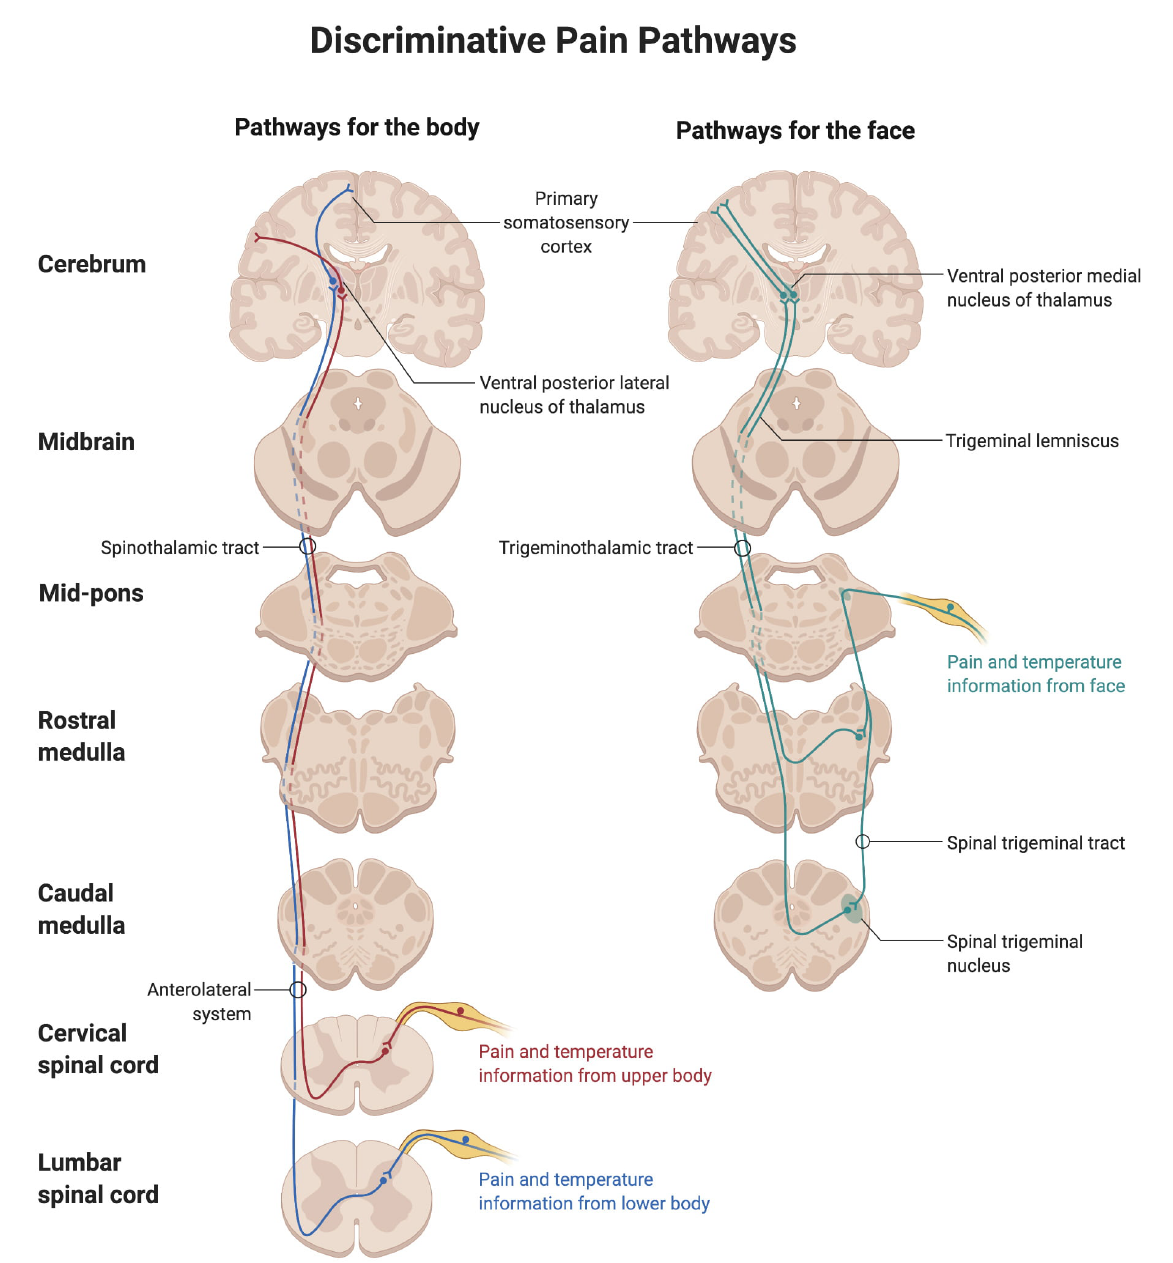
Fig. 4. An overview of the discriminative pain pathways in the body and face. The pain pathways can be affected in PTH. Nociceptors, as free nerve endings, act as afferent nerve fibers with their cell bodies located in terminal ganglion or dorsal root ganglia, terminating in the dorsal horn of the spinal cord. While all pain fibers terminate in the dorsal horn, they adopt different routes to this location, with most entering the dorsal horn via the ventrolateral bundle of the dorsal root. Second-order neurons ascend to higher brain centers in the anterolateral section of the spinal cord via spinothalamic and spinoreticular tracts. The thalamus processes somatosensory information. Descending pathways of pain play roles in modulating